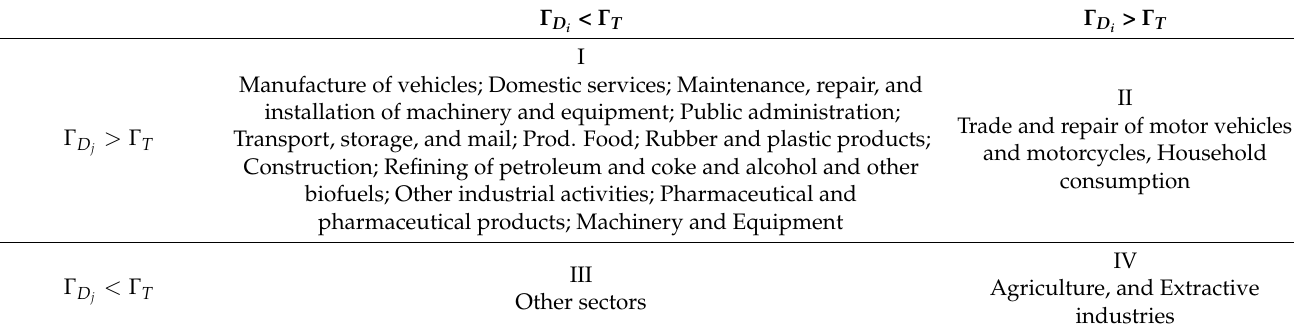
Table 3. Classification of sectors by the elasticity of water